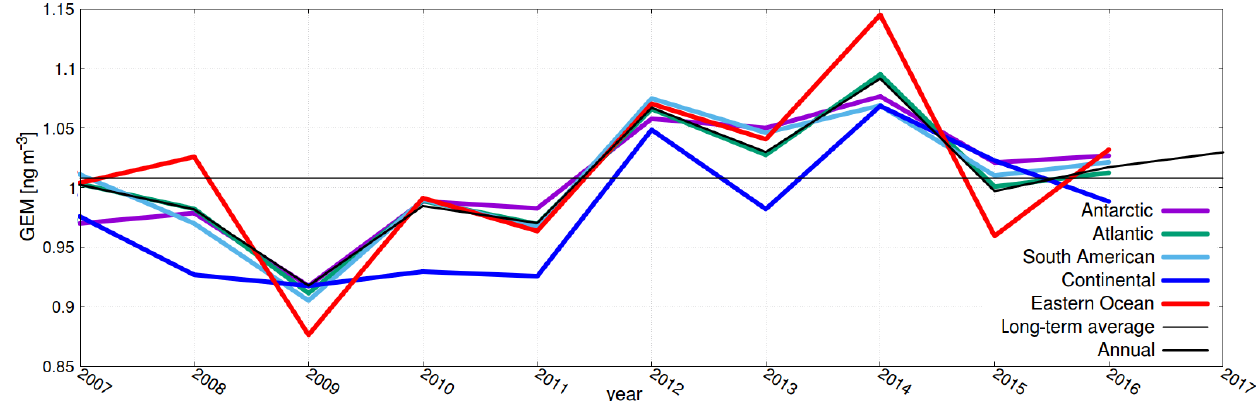
Figure 9. Annual average concentrations at Cape Point from 2007 to 2017 (black line) and regional averages (coloured lines). It can be seen that the minimum in 2009 and the maximum in 2014 is present in all source regions.